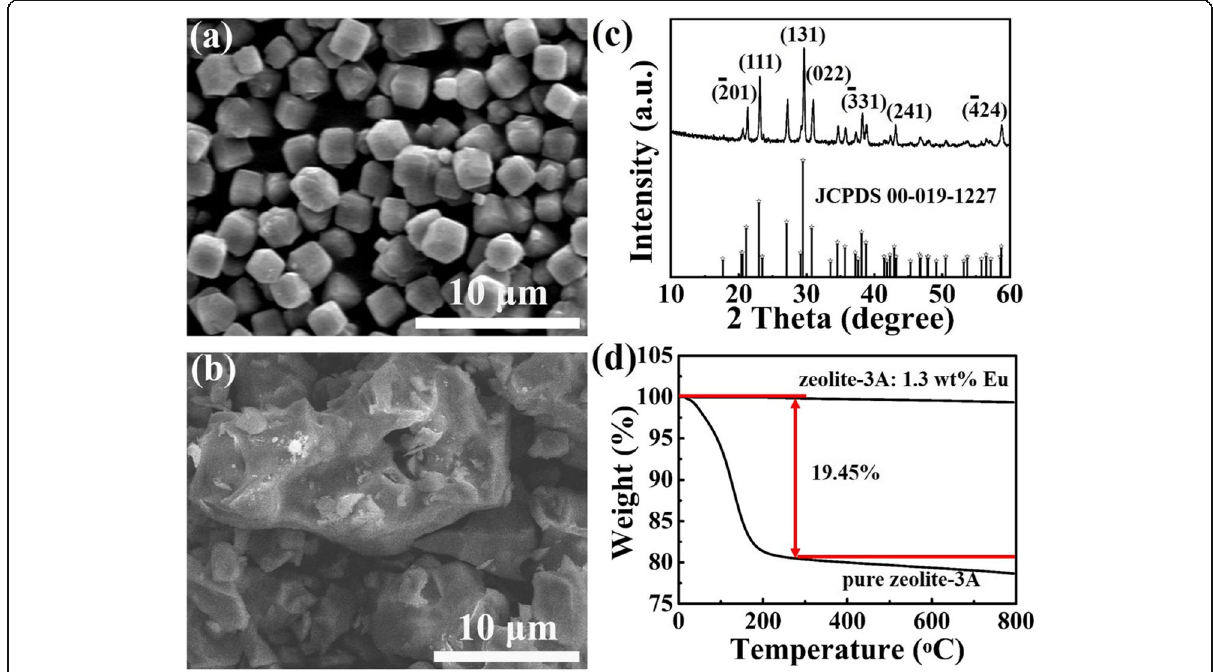
Fig. 1 The SEM images of a pure zeolite-3A and b zeolite-3A: 1.3 wt% Eu phosphor sintered at 1400 °C for 3 h. c XRD pattern of zeolite-3A: 1.3 wt% Eu phosphor sintered at 1400 °C for 3 h. d TG curves of pure zeolite-3A and zeolite-3A: 1.3 wt% Eu phosphor sintered at 1400 °C for 3